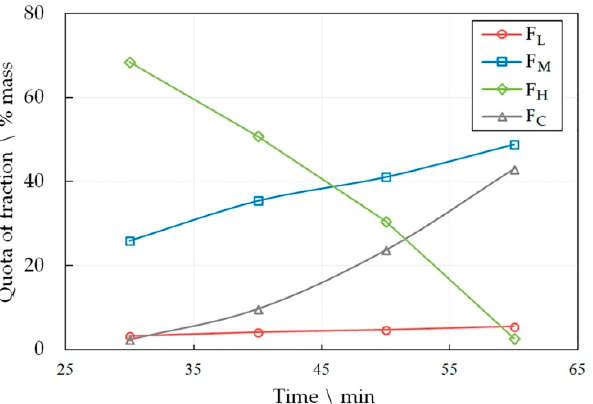
Figure 3. The dependence of the share of F L , F M , F H and F C fractions in the liquid product pyrolysis of LDPE at 590 ° С on the time of the process.